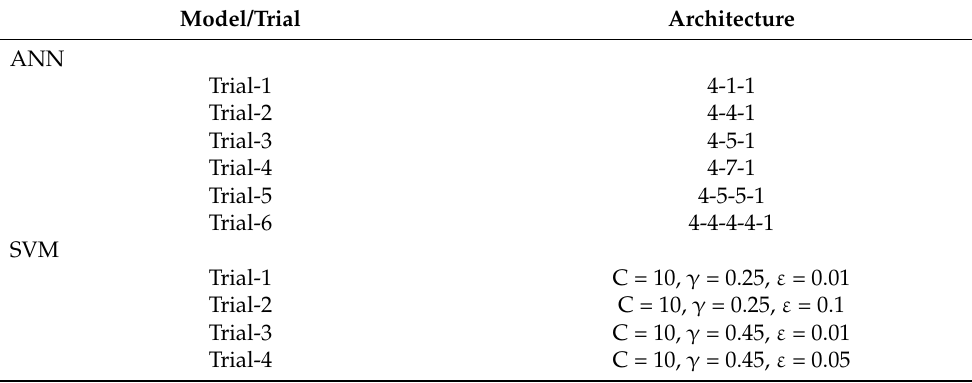
Table 3. The architecture used for the development of ANN and SVM